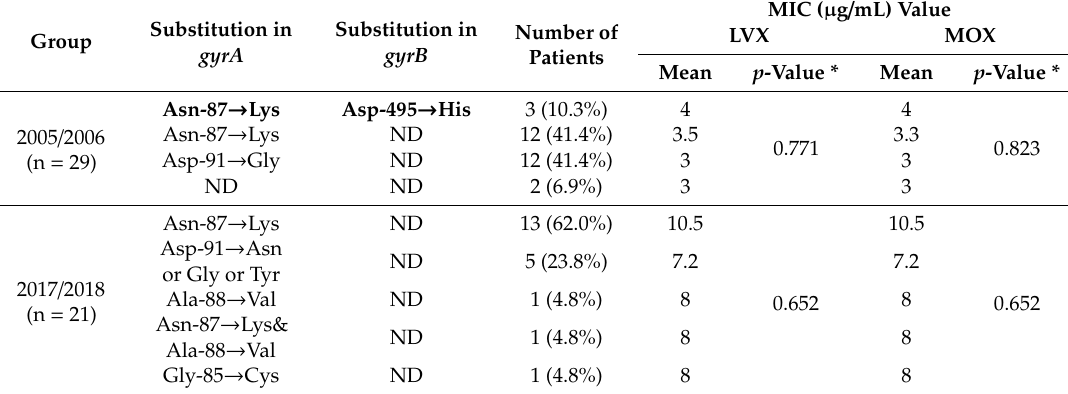
Table 3. Types of mutations in the QRDR of gyrA / B and the MIC values of fluoroquinolone resistant strains.